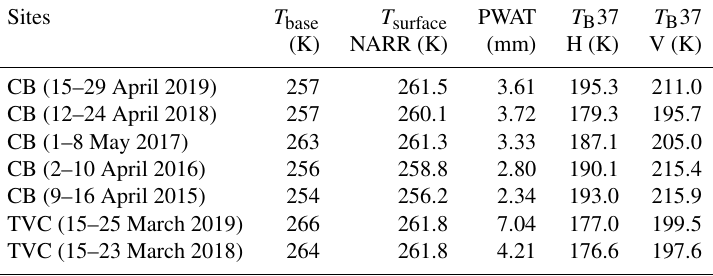
Table 2. Summary of mean basal and air surface temperatures for SMRT simulations, precipitable water (PWAT) used for atmospheric correction, and measured (corrected) T B at both vertical (V) and horizontal (H) polarization by the SSMIS sensor (platform F18).